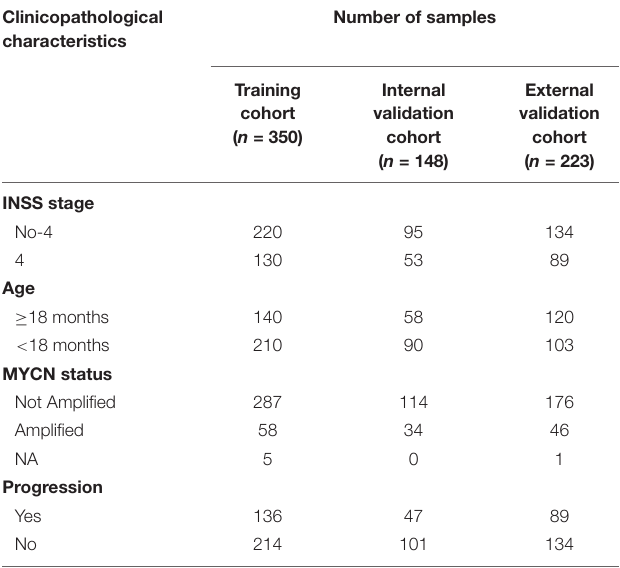
TABLE 1 | Clinicopathological characteristics of samples in cohorts. Clinicopathological